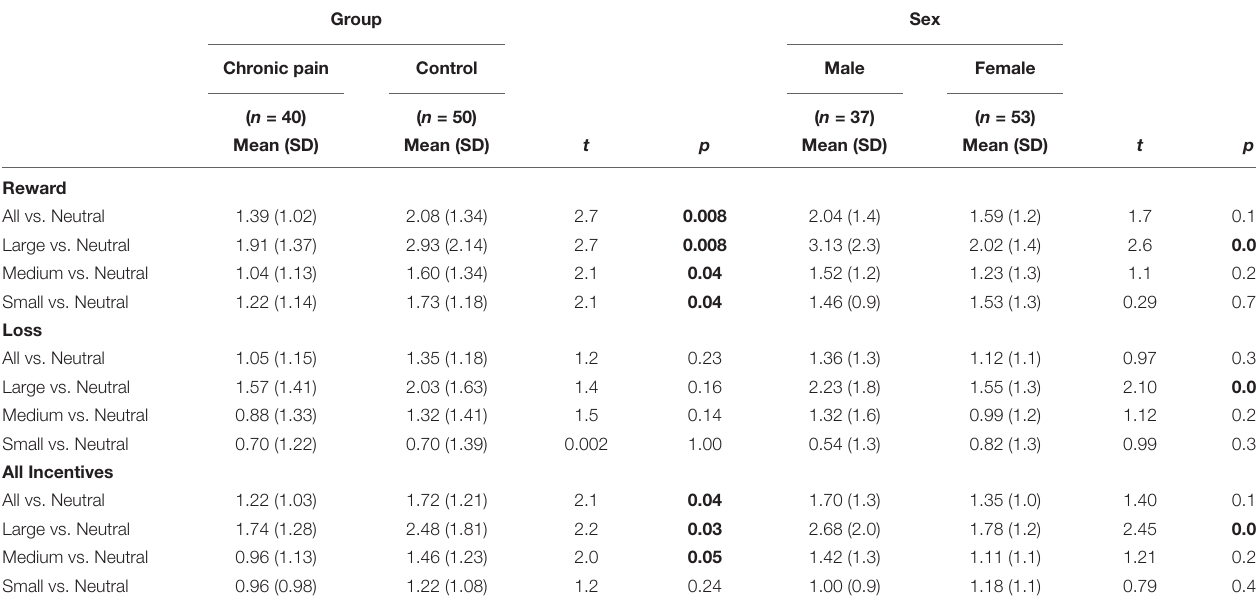
TABLE 3 | Collapsed group differences in MID activity.